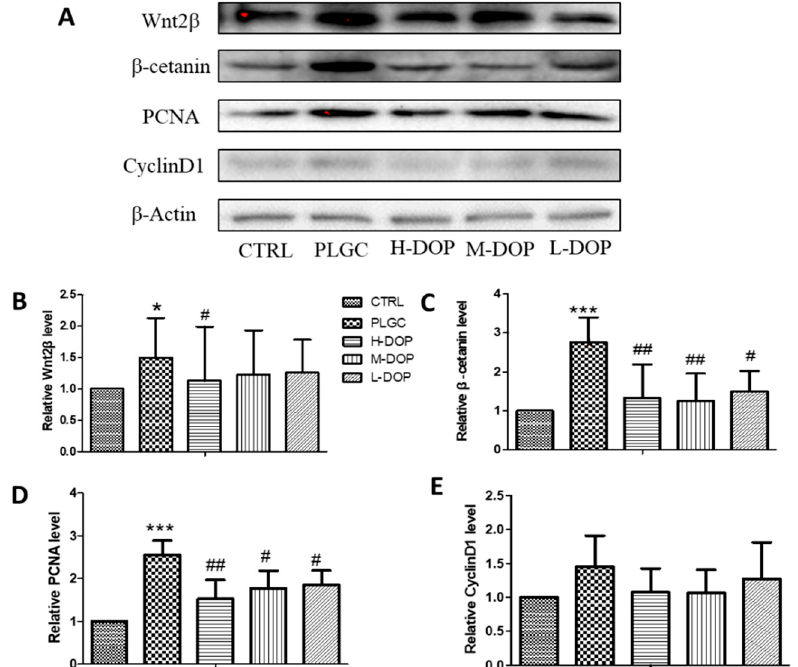
Figure 3. The effect of DOP on Wnt2 β , PCNA and β -catenin protein expression (A. the western blot bands; B-E. the relative level of Wnt2 β , PCNA, β -catenin and CyclinD1). Results from administering DOP 7 months on PLGC rat model. The relative expression for protein was analyzed and calculated by using Image lab software. Data was presented as mean ± SEM (n = 3). Statistical analyses were carried out by using one-way ANOVA and Tukey post-hoc test. * p < 0.05, ** p < 0.01 and *** p < 0.001 vs CTRL; # p < 0.05 and ## p < 0.01 vs PLGC model.